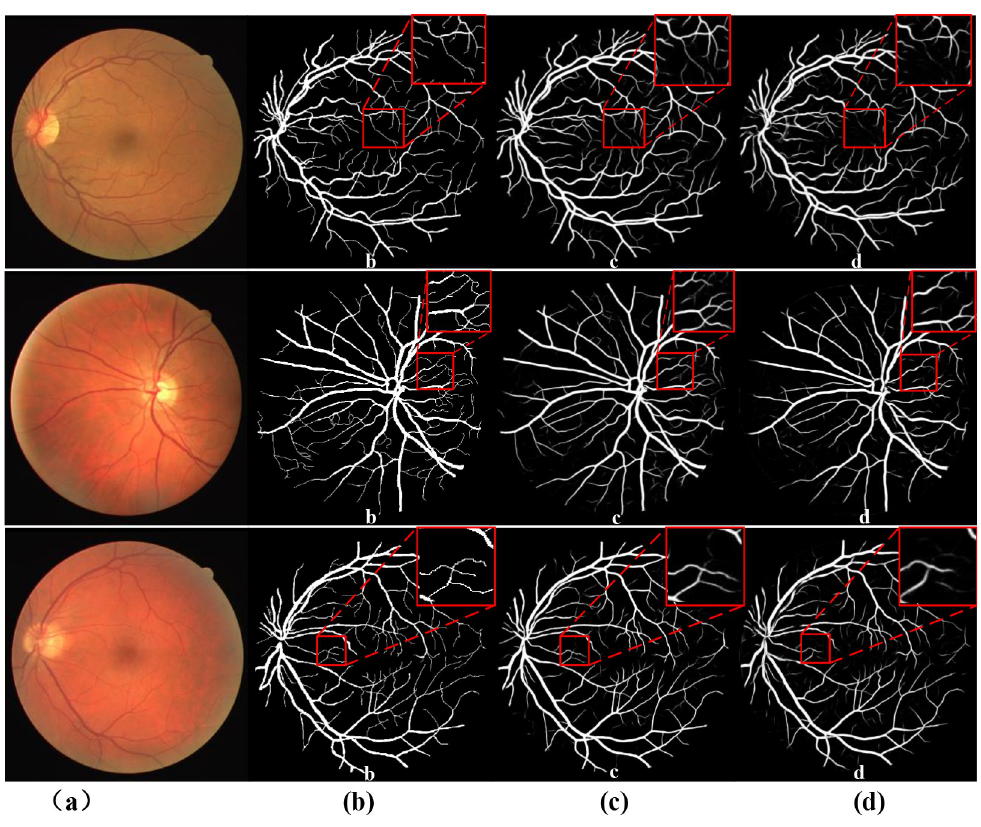
Fig 4. Comparison of ARU–Net and U–Net on DRIVE dataset: (a) color fundus images; (b) ground truth; (c) segmentation result by ARU–Net; (d) segmentation result by U–Net.